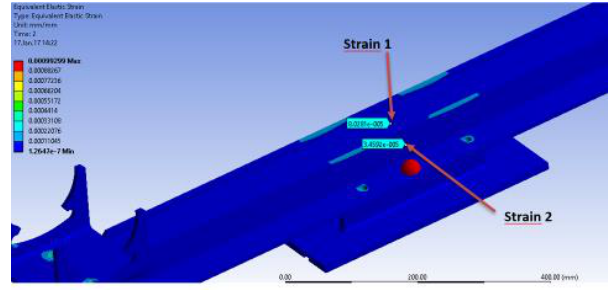
Fig. 9. Calculated strains in the area of sensors in case of the static magnetic field. In the dynamic strain calculation, only the difference between the maximum and minimum forces was considered. Tangential forces were divided into two parts, where one part of the force is the winding force, generated by the current, and the other part consists of the yoke forces. Both were applied in the component’s centre of gravity. In the case of radial force, the electromagnetic influence of the current on the winding was considered. The strain calculation results are given in Fig. 10, where it can be seen that the calculated Strain 1 (radial direction) was 7.1 µm/m and Strain 2 (tangential direction) was 10.9 µm/m.